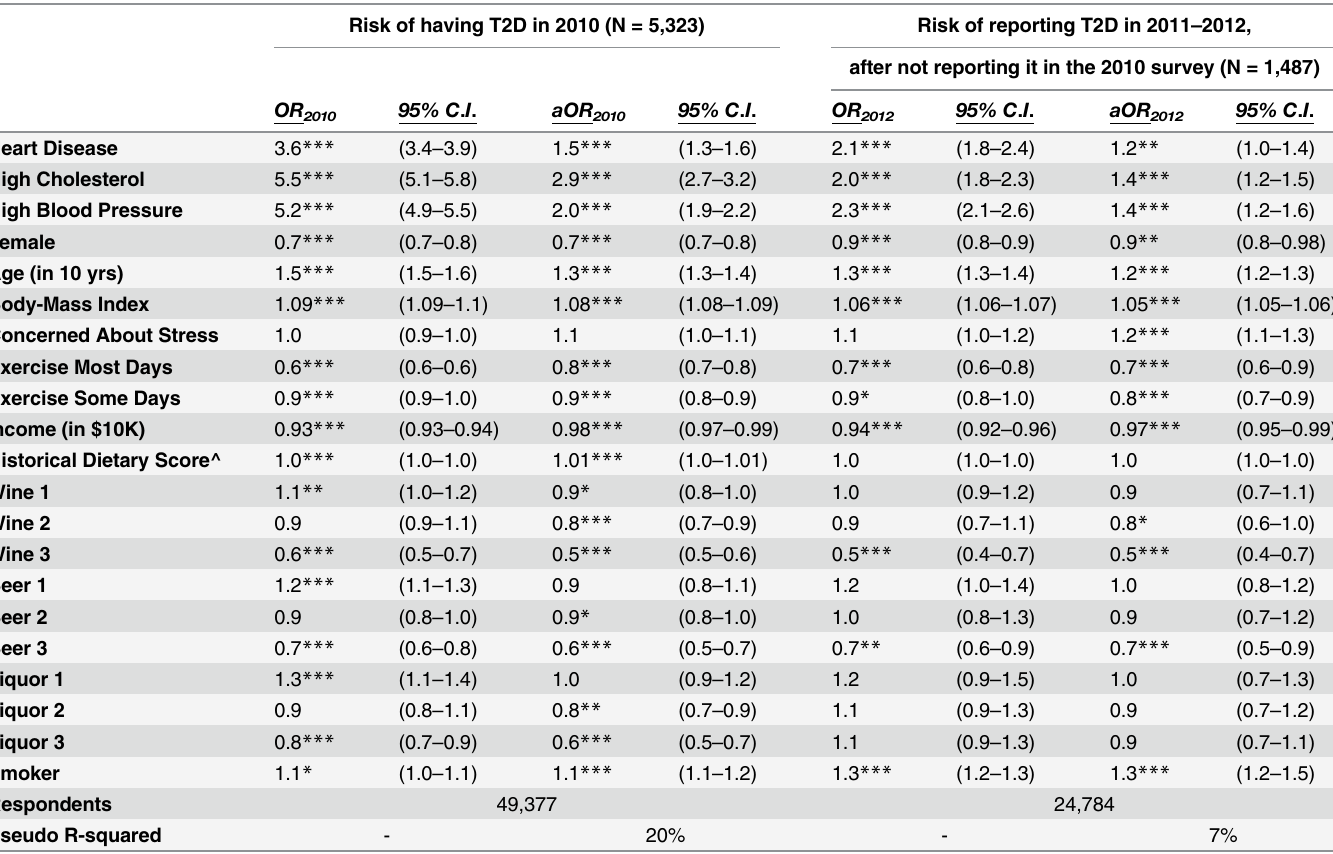
^ The results in this table use Healthshare to represent diet score. Virtually identical results are estimated when USDAscore is used. robust to clustering at the household level. Race, region, and marital status were controlled for in the multivariate analyses but are not presented in the table to conserve space. Levels of signi fi cance are represented